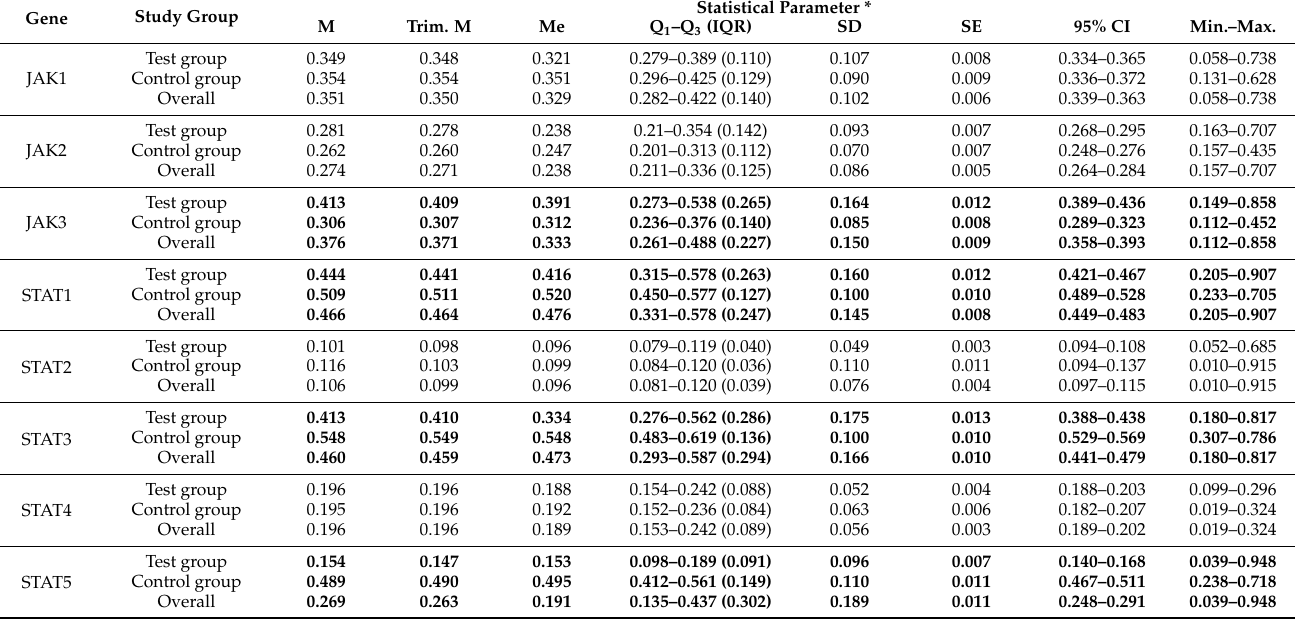
Table 2. Detailed descriptive statistics for mRNA gene expression (2 − ∆ CT ) by study group.